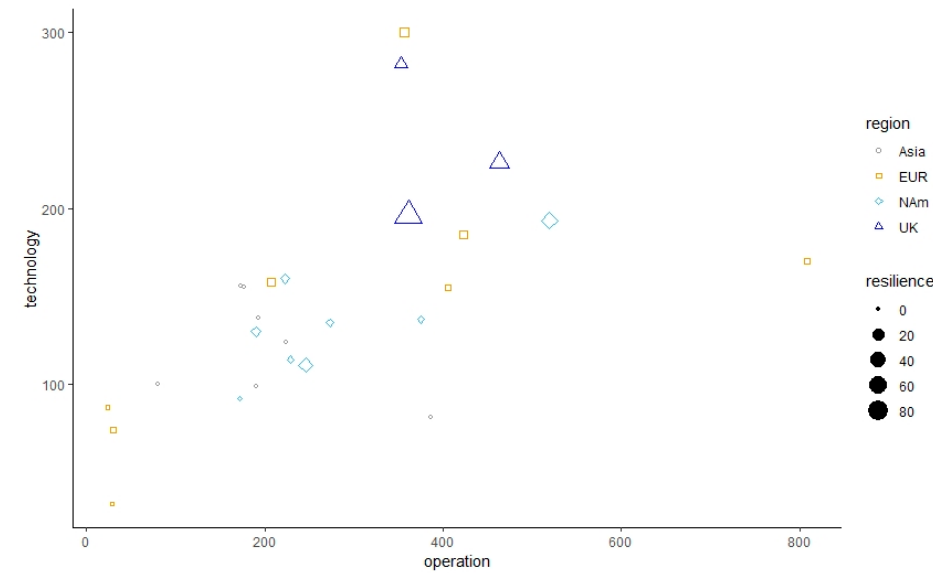
Figure 2. Occurrence of the term resilience (operation resilience) plotted against the frequency of technology and operation as found in the annual reports.